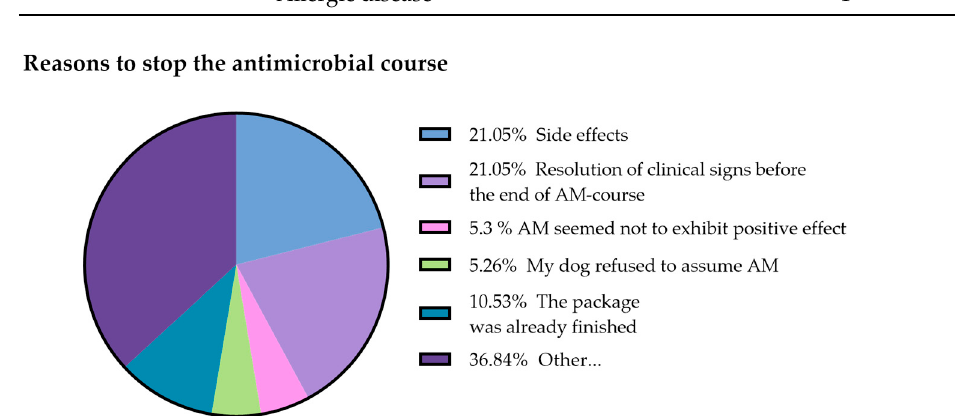
Figure 1. How owners purchased oral antibiotics without veterinary consultation. Two values in the fi gure (“AM was given by a family member or a friend” and “AM was purchased on internet”) were not plo tt ed because they were zero. AM: antimicrobials.